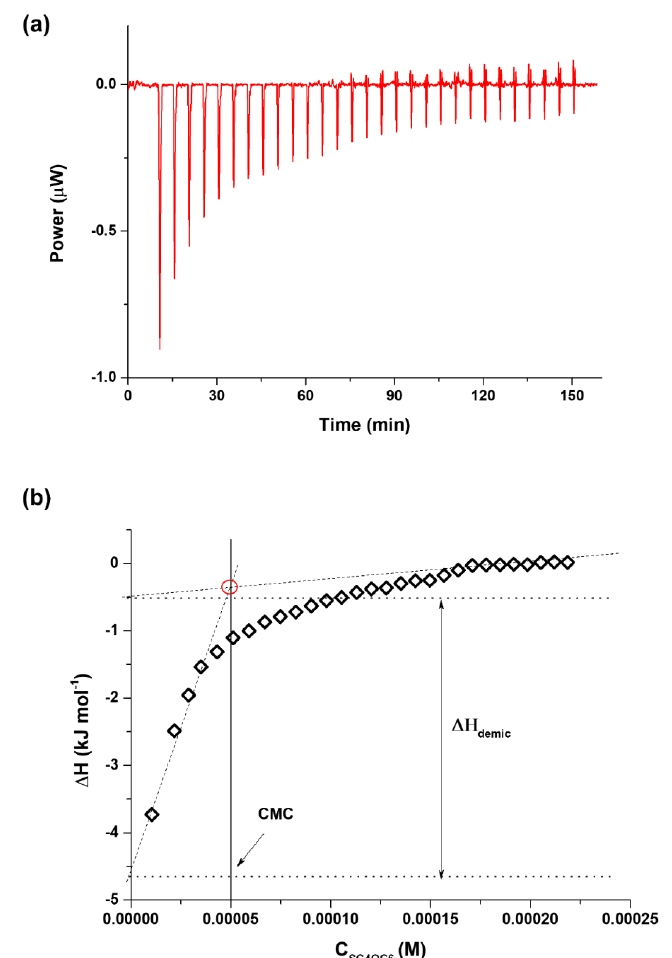
Figure 3. ( a ) ITC titration of SC4OC6 1 mM in 10 mM phosphate buffer at 25 °C; ( b ) reaction enthalpy as a function of the total surfactant concentration (C SC4OC6 ) in the calorimetric cell. The calorimetric curve did not show clear sigmoidal features; thus, a linear fit of the datasets in the lower and upper concentration domain had to be performed, as suggested by different authors [43,44]. The intercept of the two straight lines was then determined, with the difference between the two intercepts yielding the value of the enthalpy of mi- cellization. The CMC value was estimated by taking the concentration value at the inter- section point of the linear fits at the lower and upper concentration domains of the en- thalpogram [45,46]. The thermodynamic parameters obtained are reported in Table S1 along with the CMC and ∆H values determined in plain water at 25 °C (Figure S1) for the sake of comparison. In 10 mM phosphate buffer (I = 20 mM), the CMC of SC4OC6 resulted significantly lower (0.05 mM) if compared to that found in plain water (0.49 mM), as expected for am- phiphilic molecules in the presence of salts [47,48]. Indeed, it has been widely reported that increasing the ionic strength induces a decrease of the CMC value, e.g., micelle for- mation occurs at a lower total surfactant concentration [49 – 52]. The lower CMC value is due to the decrease of the surface charge of the micelles caused by the counterion adsorp- tion that makes the overall self-aggregation process more favored, despite the reduction